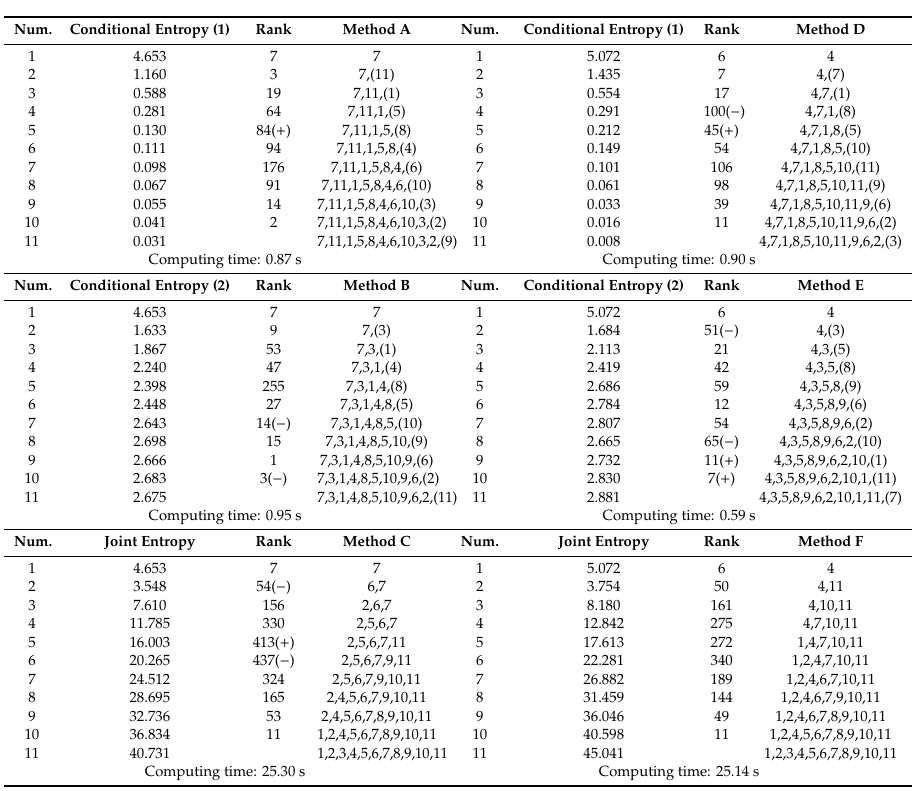
Table A7. Results of a select optimal rain gauge network of methods (weight: monthly average precipitation by